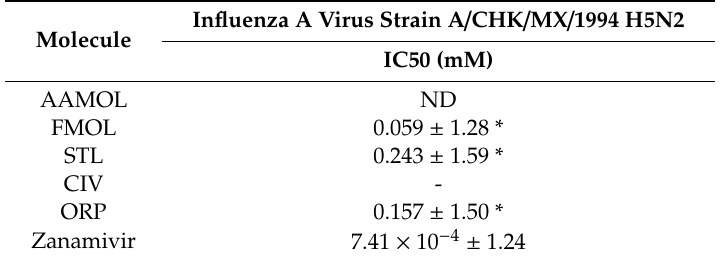
Table 2. IC 50 of molecules against influenza A virus strain A / CHK / MX / 1994